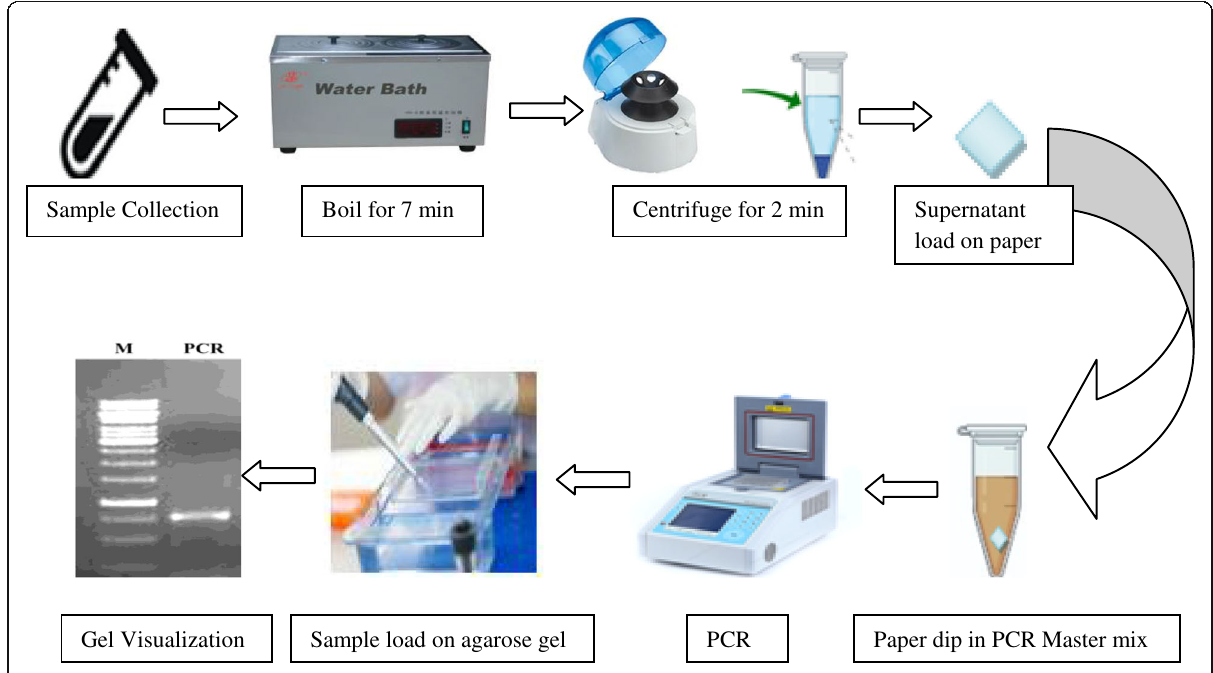
Fig. 1 Schematic illustration of the developed Paper based PCR